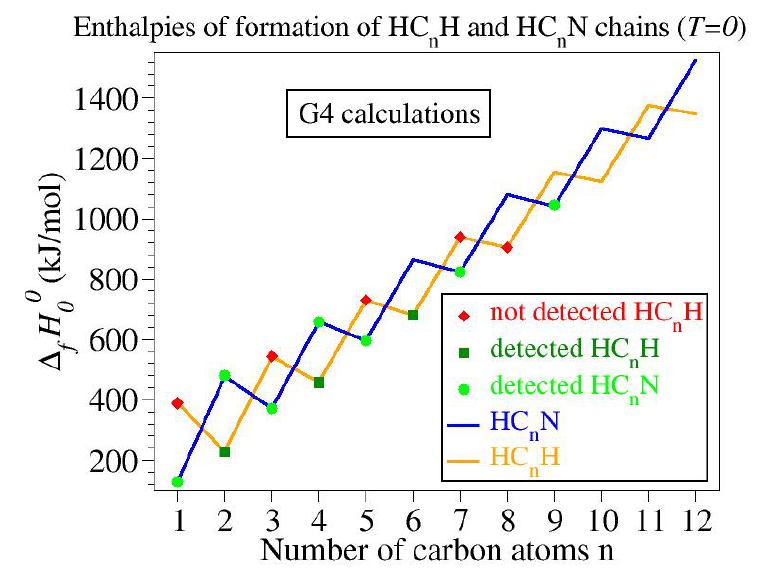
Figure 1. Enthalpies of formation ∆ f H 0 of some astronomically observed HC n N chains are larger 0 than enthalpies of formation of shorterHC n H chains not yet detected in space. On this basis, there is no reason to assume that HC n H species are less numerous in space than HC n N species, although, as visible in this figure, HC n N molecules already astronomically observed are much more numerous than HC n H